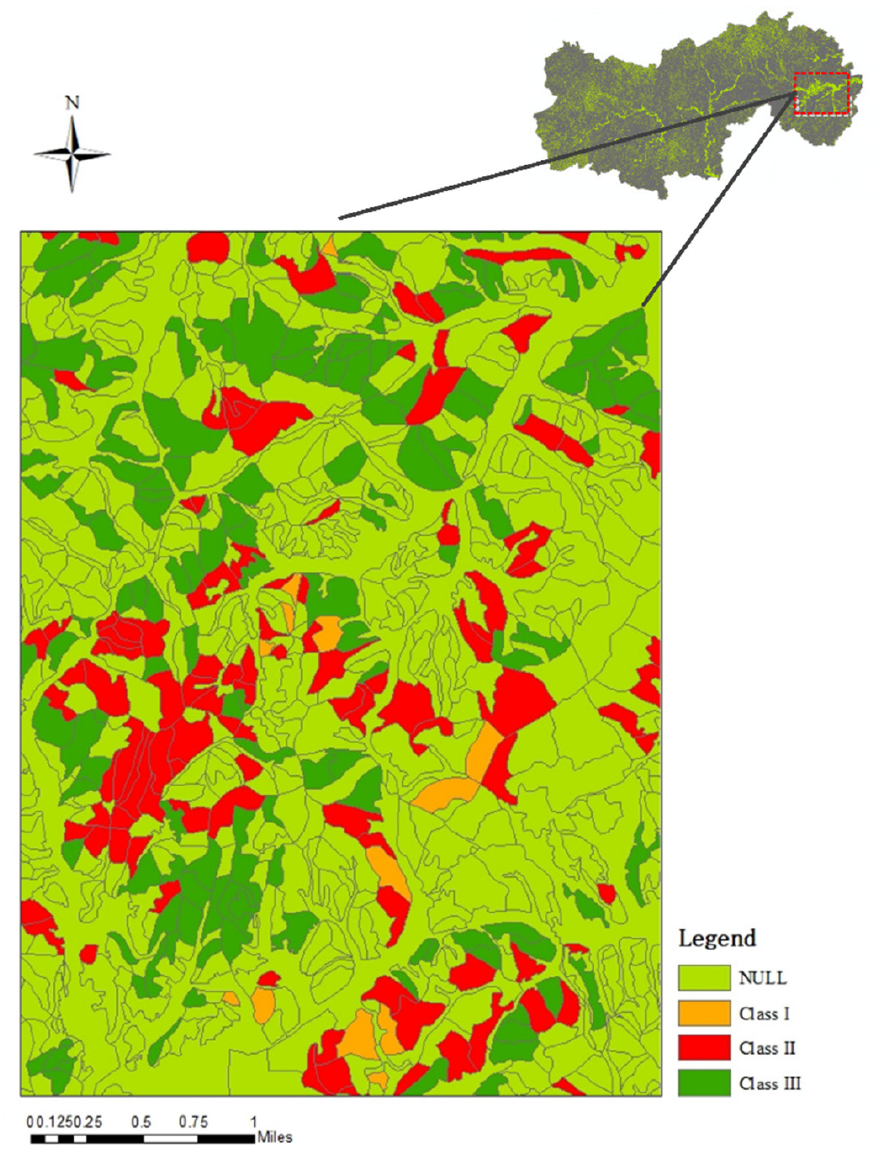
Figure 7. The site quality grade prediction of a Chinese fir plantation in Lin’an District.